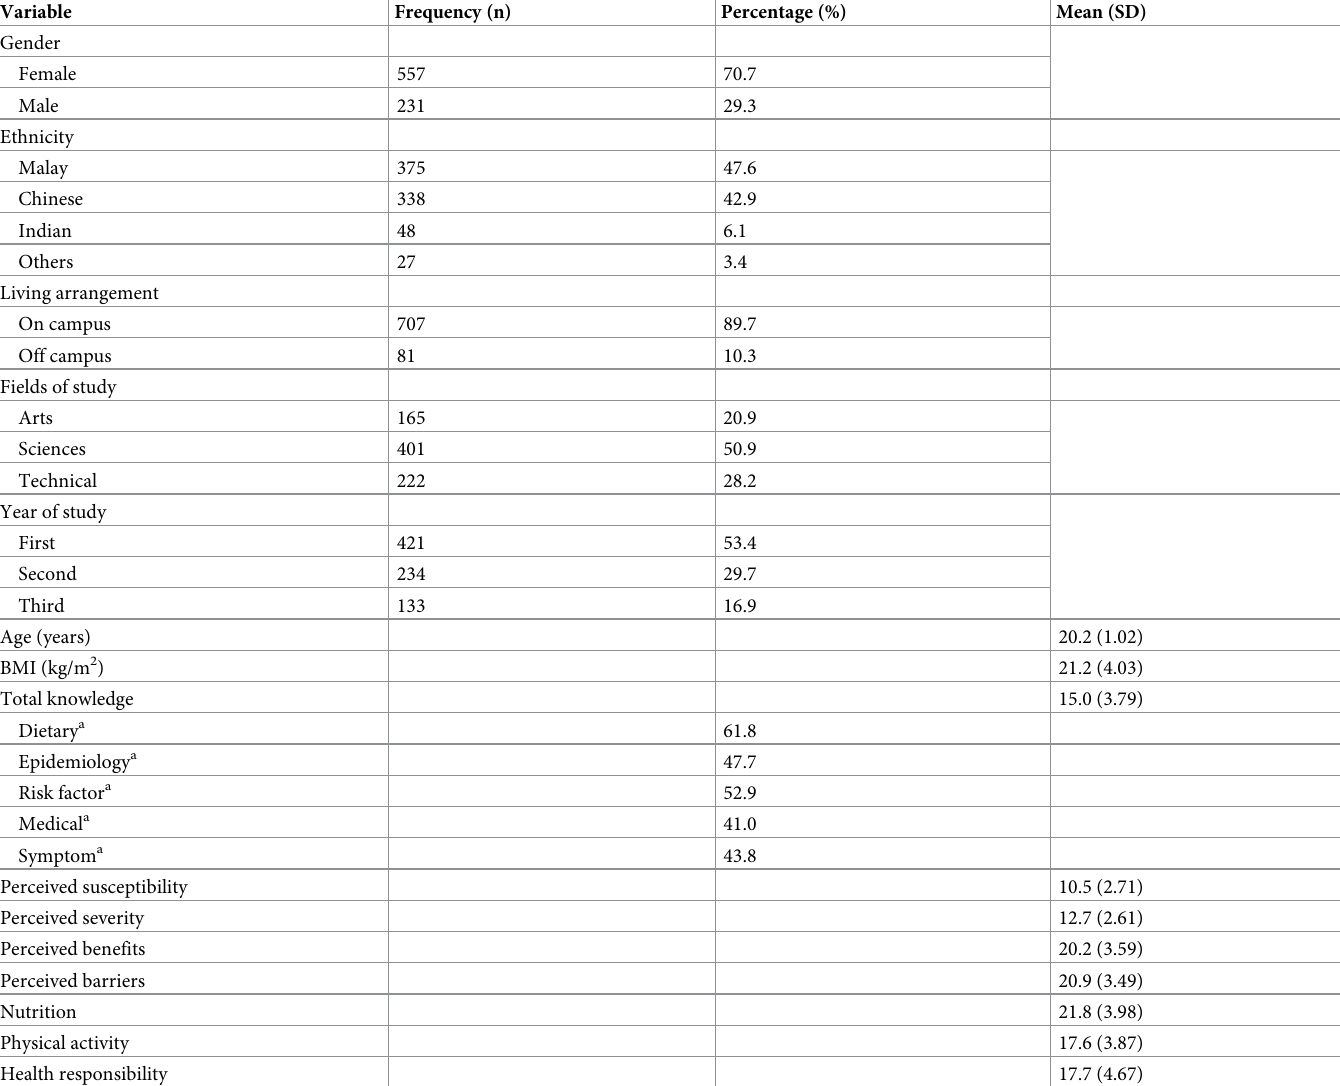
Table 1. Socio-demographic characteristics of the sample and descriptive statistics of measured variables, (n = 788).